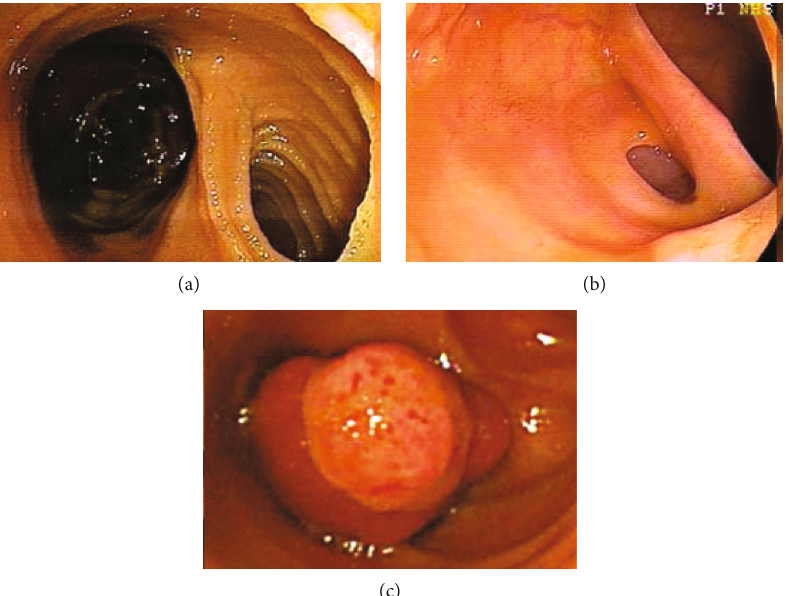
Figure 1: Endoscopy showing a large ostium of Meckel ’ s diverticulum (a); endoscopy showing a small ostium of Meckel ’ s diverticulum (b); endoscopy showing an inverted polypoid mass from a Meckel ’ s diverticulum